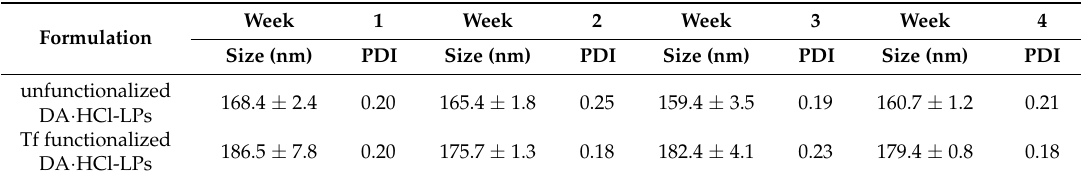
Table 2. Particle size ± SD and PDI vales of DA · HCl-LPs unfunctionalized and functionalized with Transferrin.